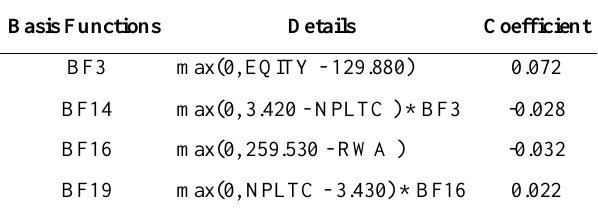
Table 10: Basis Functions of NPLTC